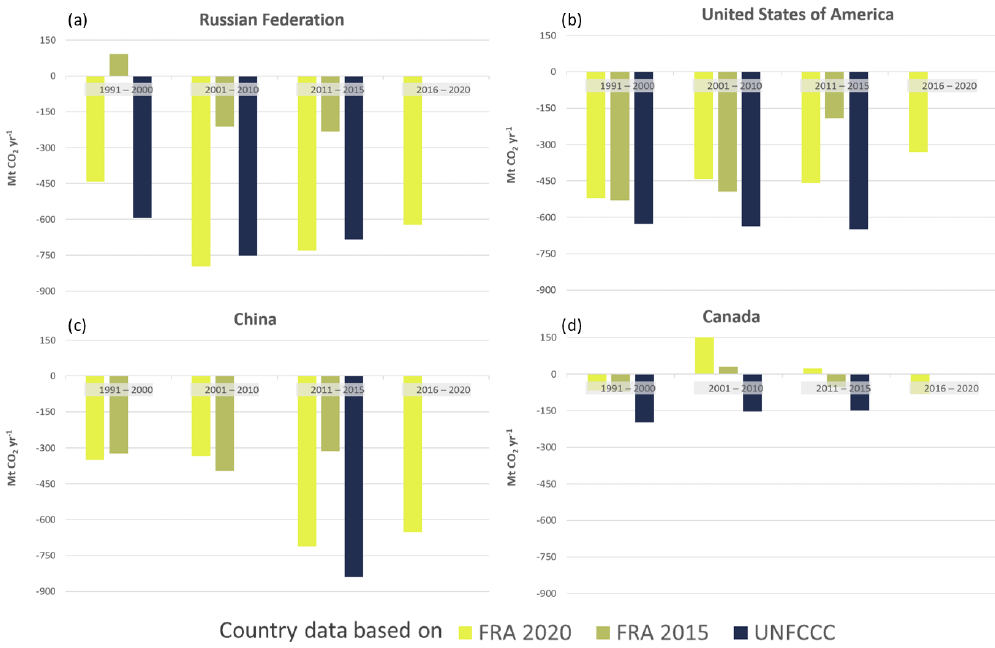
Figure 6. Comparison of estimates of emissions/removals on forest land (FL) for the Russian Federation (a) , USA (b) , China (c) and Canada (d) in MtCO 2 yr − 1 , based on FRA 2020 (acid green) and FRA 2015 (olive green), to country data reported to the UNFCCC (cadet